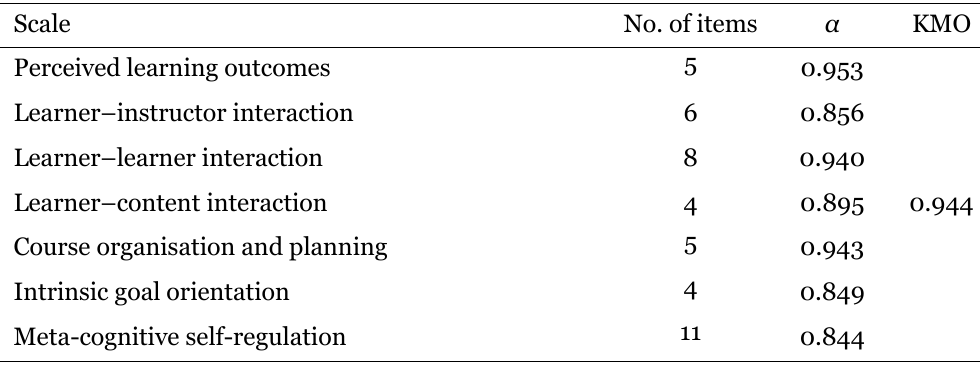
Scales and Reliability Estimates